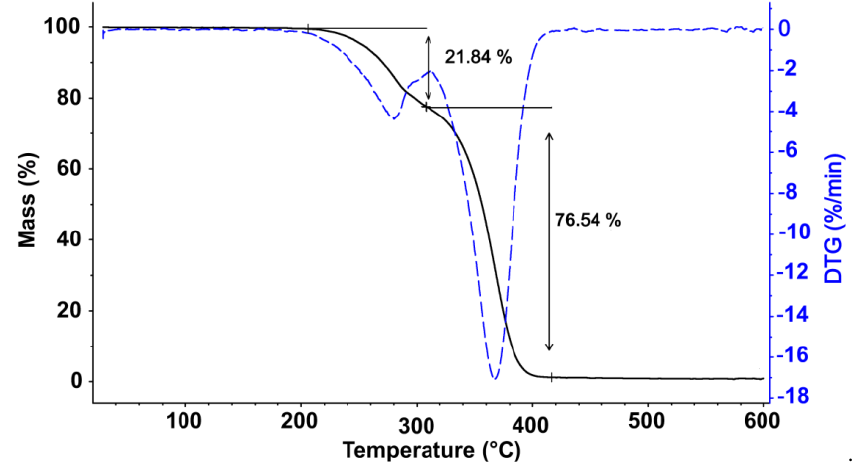
Figure 2. TGA ( ) and derivative thermogravimetry (DTG) ( ) curves for pure FPUF under N 2 Figure 2. TGA (—) and derivative thermogravimetry (DTG) ( − − − ) curves for pure FPUF under atmosphere. N 2